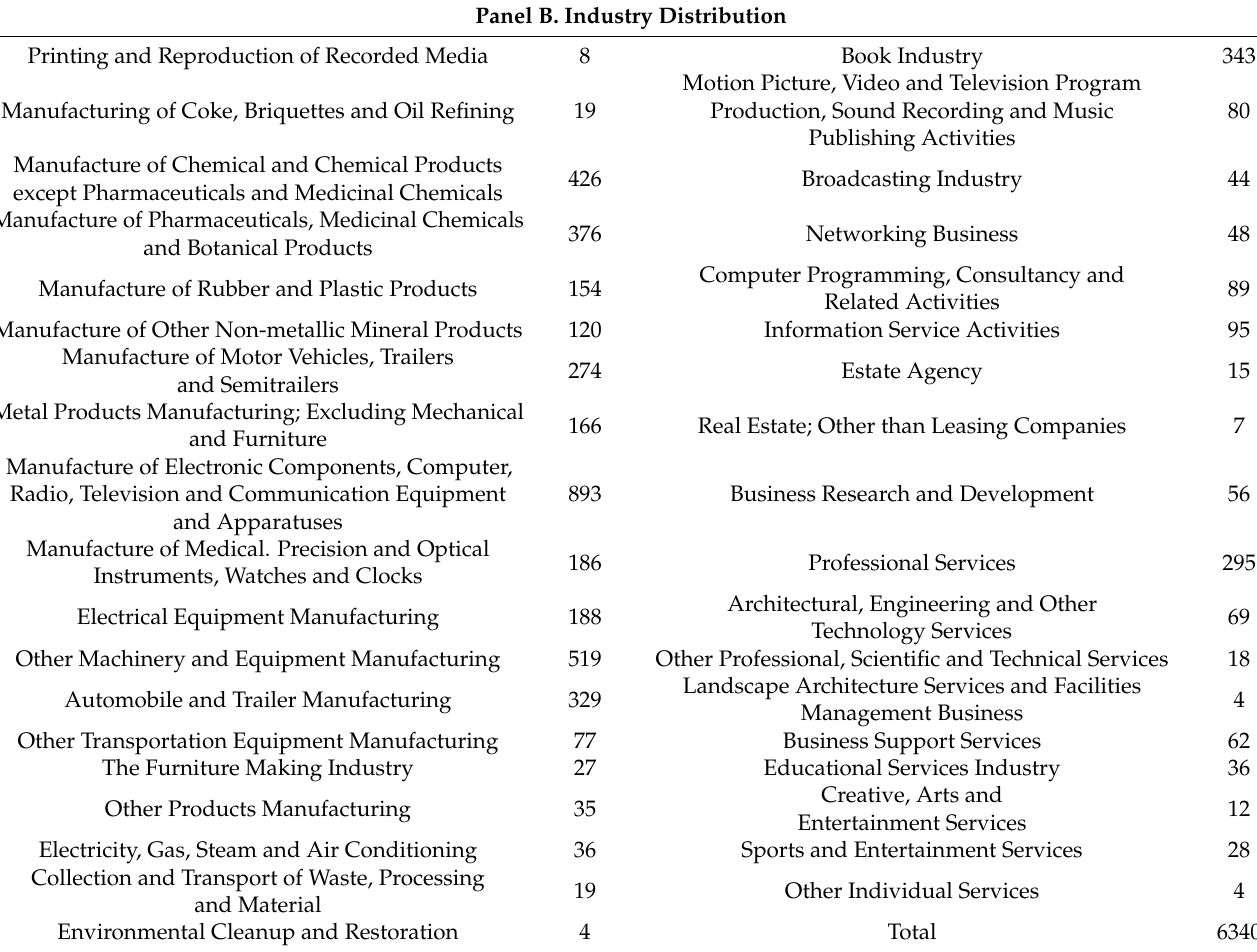
Table 2. Cont. Panel B. Industry